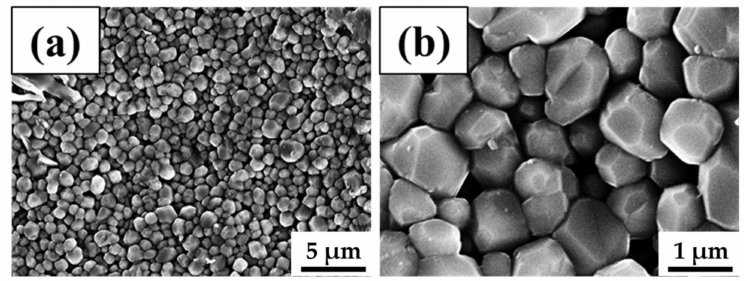
Figure 3. ( a ) Low- and ( b ) high-magnification SEM images of Nd 2 Fe 14 B bonded